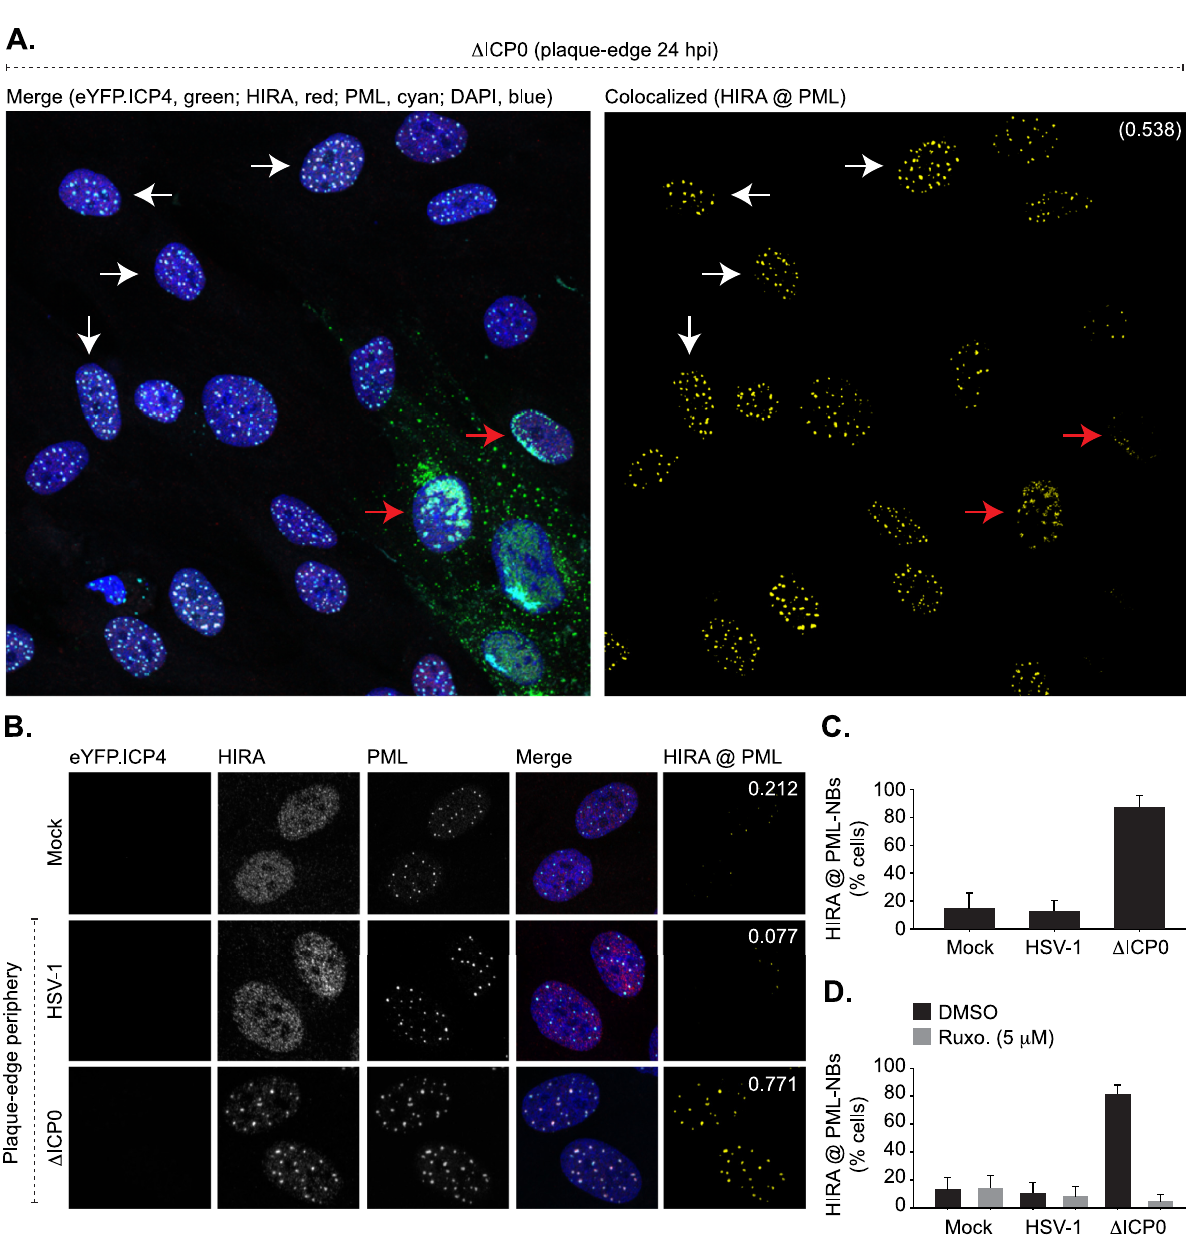
Fig 2. HSV-1 induced activation of innate immune signalling promotes HIRA localization at PML-NBs in a JAK-dependent manner. HFt cells were mock infected or infected with 0.001 or 2 PFU/cell of WT or Δ ICP0 HSV-1 recombinant viruses expressing eYFP.ICP4, respectively, to enable plaque-formation to occur. Infected cell monolayers were fixed and permeabilized at 24 hpi, and the nuclear localization of HIRA (red) and PML (cyan) were evaluated by indirect immunofluorescence. Nuclei were stained with DAPI (blue). (A) Wide-field plaque-edge image showing the nuclear localization of HIRA and PML in cells in close proximity to a developing Δ ICP0 plaque-edge (eYFP.ICP4, green). Corresponding wide-field images for mock and HSV-1 infected cells are shown in S2 Fig. Cut mask (yellow) highlights regions of colocalization between HIRA and PML. Weighted colocalization coefficient is shown. Arrows highlight examples of cells that are either positive (red) or negative (white) for eYFP.ICP4 expression. (B) Nuclear localization of HIRA and PML in mock or eYFP.ICP4 negative cells at the periphery of developing WT or Δ ICP0 plaque-edges (equivalent to white arrows in A). (C) Quantitation of the population of eYFP.ICP4 negative cells showing HIRA colocalization at PML-NBs (as shown in A, B, and S2 Fig). n � 500 cells per sample population derived from four independent infections. Means and standard deviations (SD) shown. (D) Quantitation of the population of eYFP.ICP4 negative cells positive for HIRA colocalization at PML-NBs in mock, WT, or Δ ICP0 HSV-1 infected cells treated with DMSO or the JAK inhibitor Ruxolitinib (Ruxo; 5 μ M). n � 500 cells per sample population derived from four independent infections. Means and SD shown. Wide-field images for Δ ICP0 HSV-1 infected and DMSO or Ruxo treated cell monolayers are shown in S4 Fig.